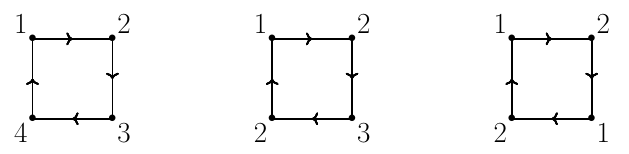
Figure 16 . The three types of squares that enter a quadrangulation. The vertices denote the punc- tures.